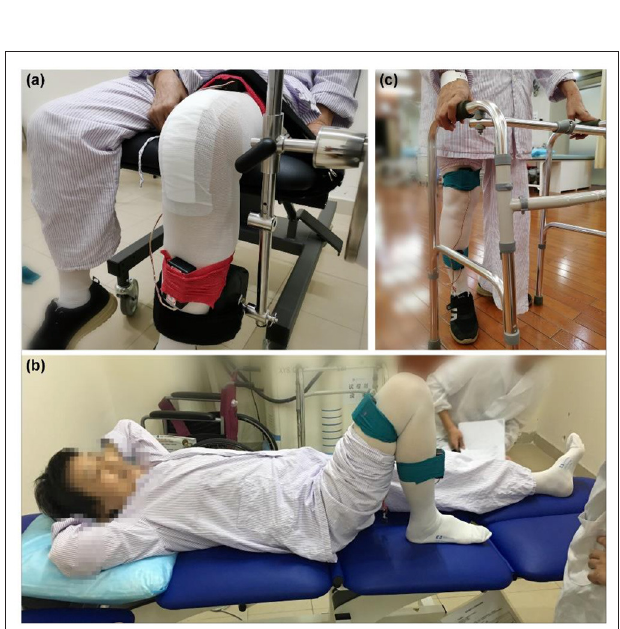
FIGURE 3 | Three flexion-extension activities data collection. (a) Passive flexion-extension: Participants do not need to exert any force, and swing activities driven by BTE Primus RS. (b) Active flexion-extension: Participants need to complete the flexion-extension activity independently, and the